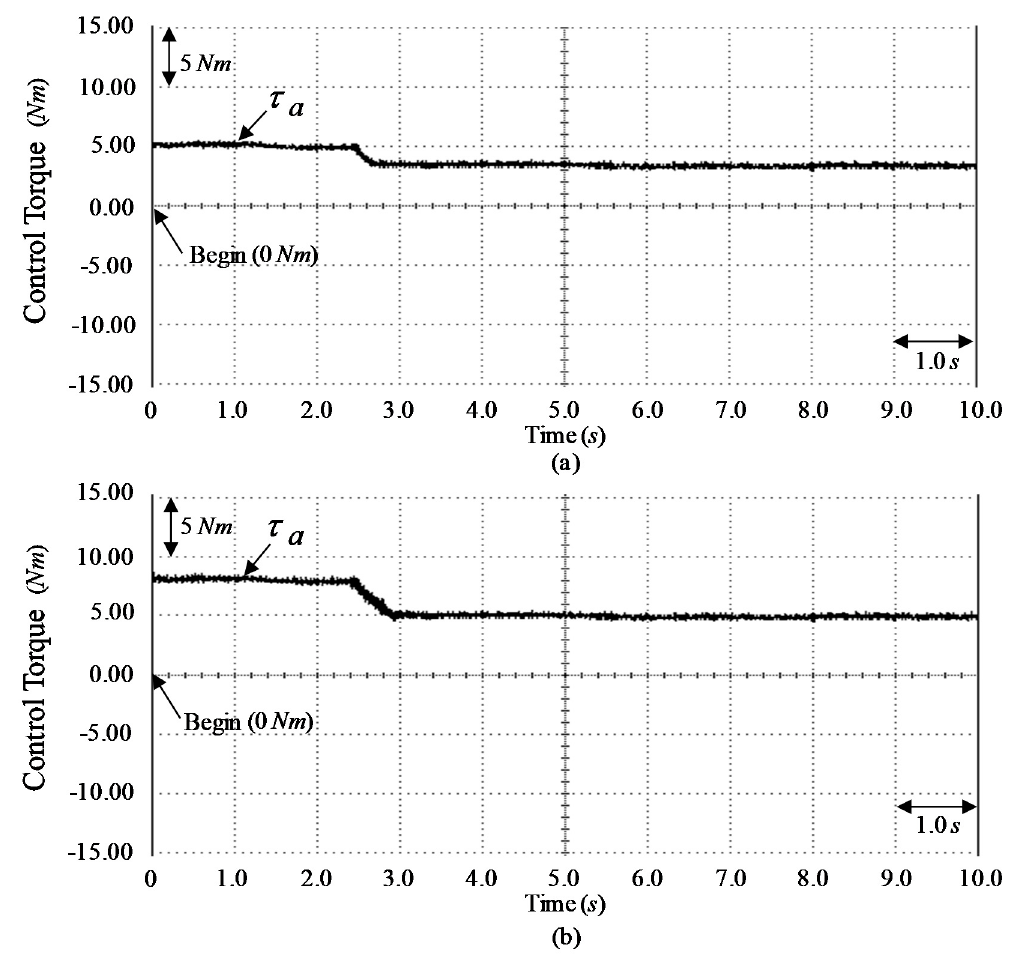
Figure 14. Tested results for the SIM expelling CVT organized system by using the controller CT3: ( a ) response of developed torque τ a at the tested Event E1 case, ( b ) response of developed torque τ a at the tested Event E2